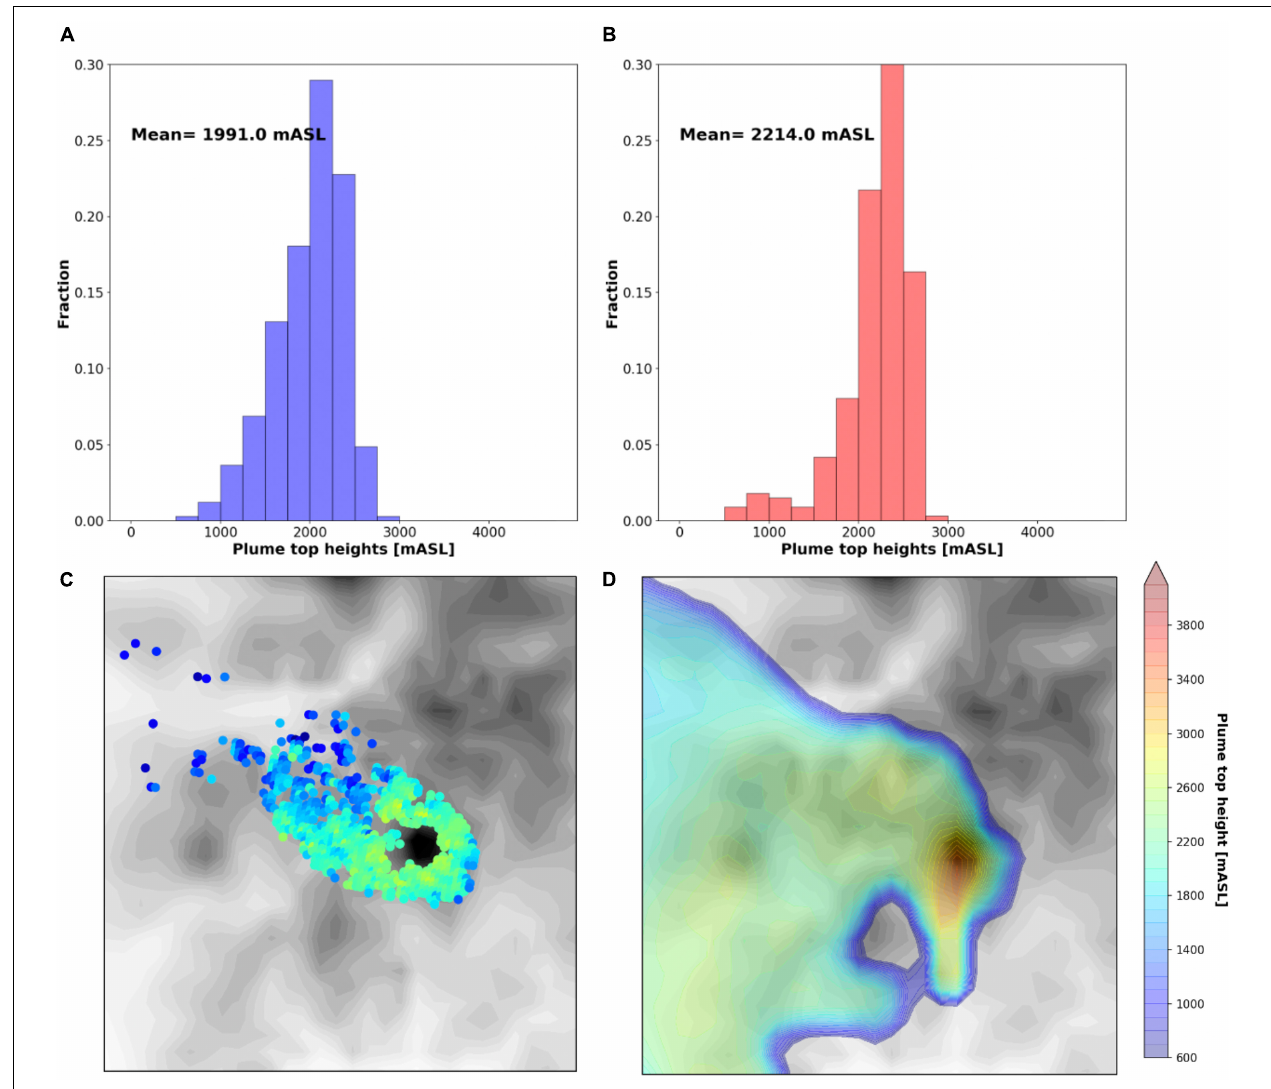
FIGURE 4 | Multi-angle imaging spectroradiometer (MISR)-derived (A,C) vs. modeled (B,D) plume top heights for the Cougar Creek Fire on August 18th, 2015 at 19:14 UTC. Panels (A,B) show histograms of plume top heights near the center of the fire plume while panels (C,D) show spatial distribution of the same plume top heights. The gray shaded contours represent terrain heights where black corresponds to higher terrain heights while the lighter gray shading represents lower terrain heights.